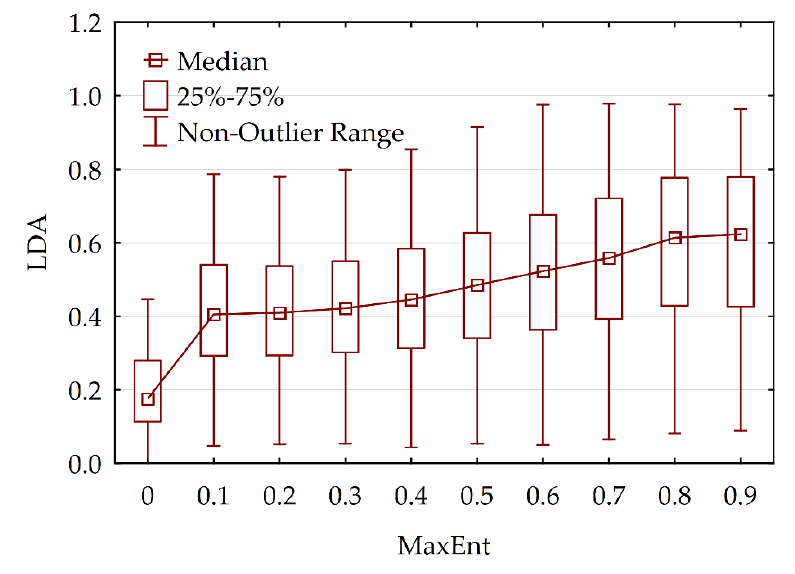
Figure 6. Box – whisker plot of cross-tabulation between MaxEnt and Linear Discriminant Analysis LDA integrated models.